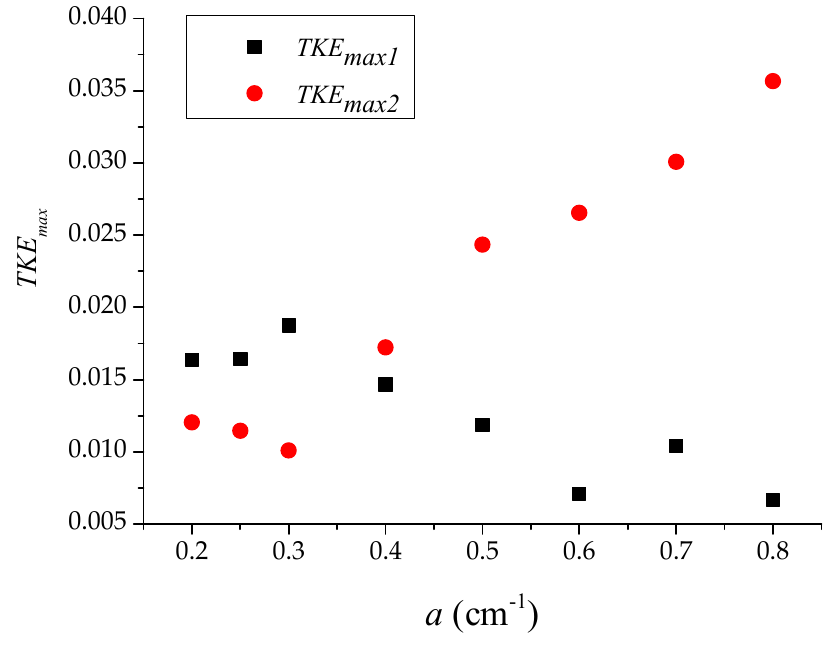
Figure 4. Comparison of TKE max1 and TKE max2 .